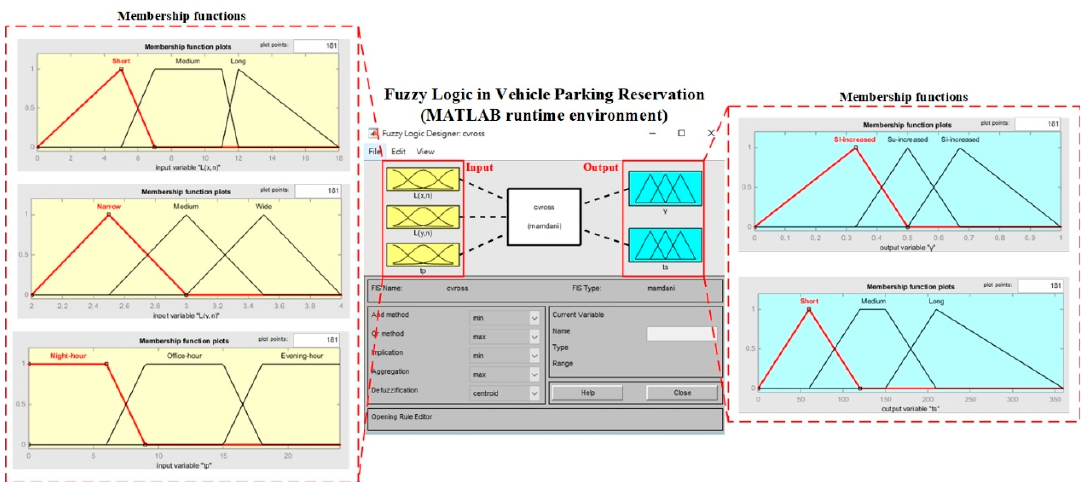
Figure 14. Fuzzy logic in MATLAB runtime compiler.